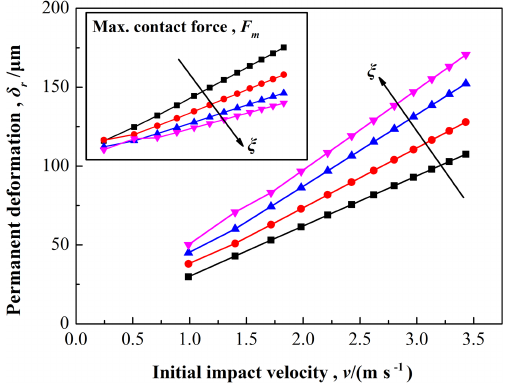
Figure 18. The permanent deformation as a function of initial im- pact velocity, and with ξ varied from 1 / 8 to 7 /